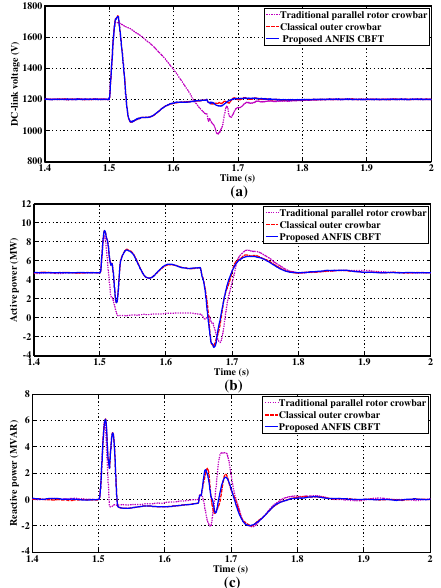
Fig. 11 Comparison of measured values for traditional, classical, and proposed protection techniques during three-phase to ground fault ( a ) DC-link voltage; ( b ) active power; ( c ) reactive